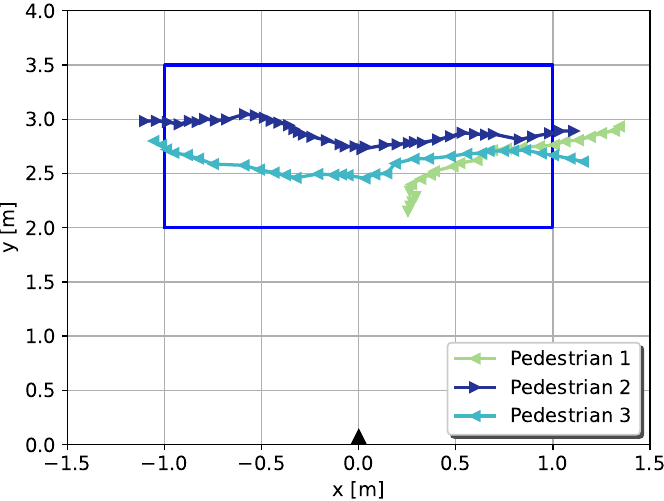
Figure 15. Example of three pedestrians’ tracks after they have been detected by the system. The track of pedestrian 1 is from the first scenario, and tracks of pedestrians 2 and 3 are from the fourth scenario. The radar’s position and orientation are marked with a black